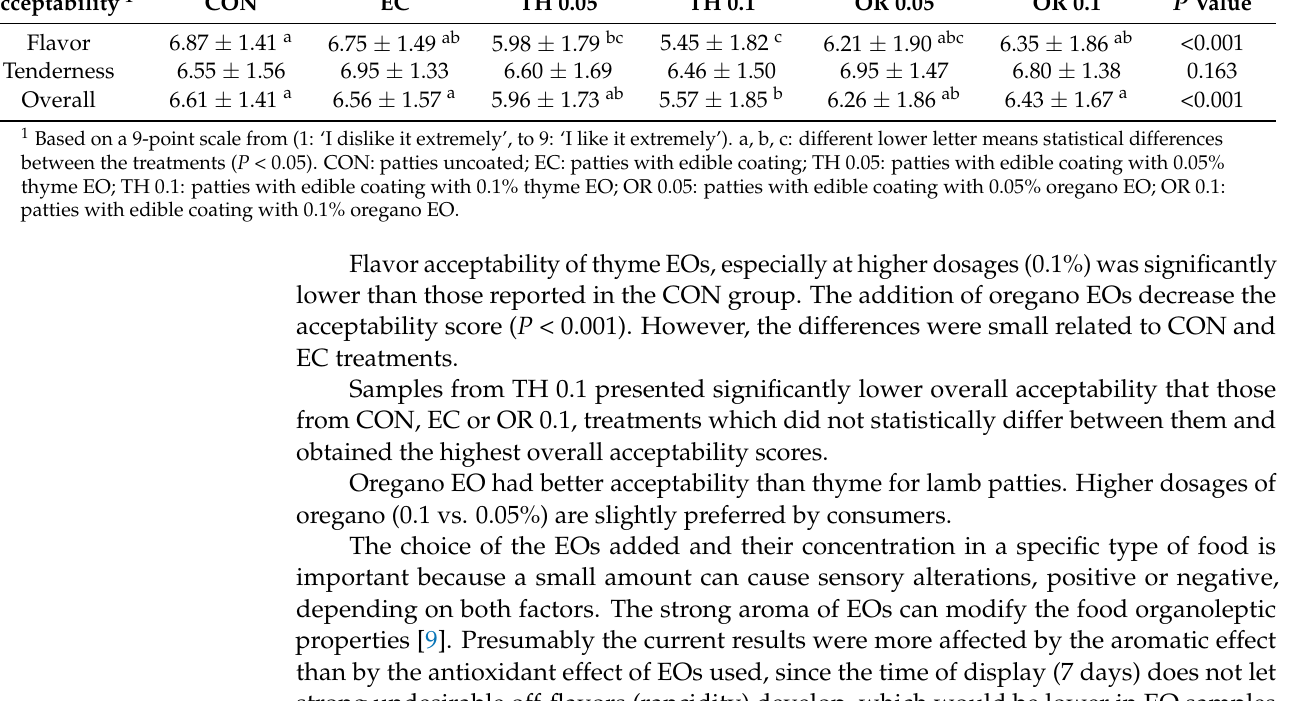
Table 6. Consumer acceptability (n = 80) of lamb patties with edible coat and essential oils (mean ± standard error). Acceptability